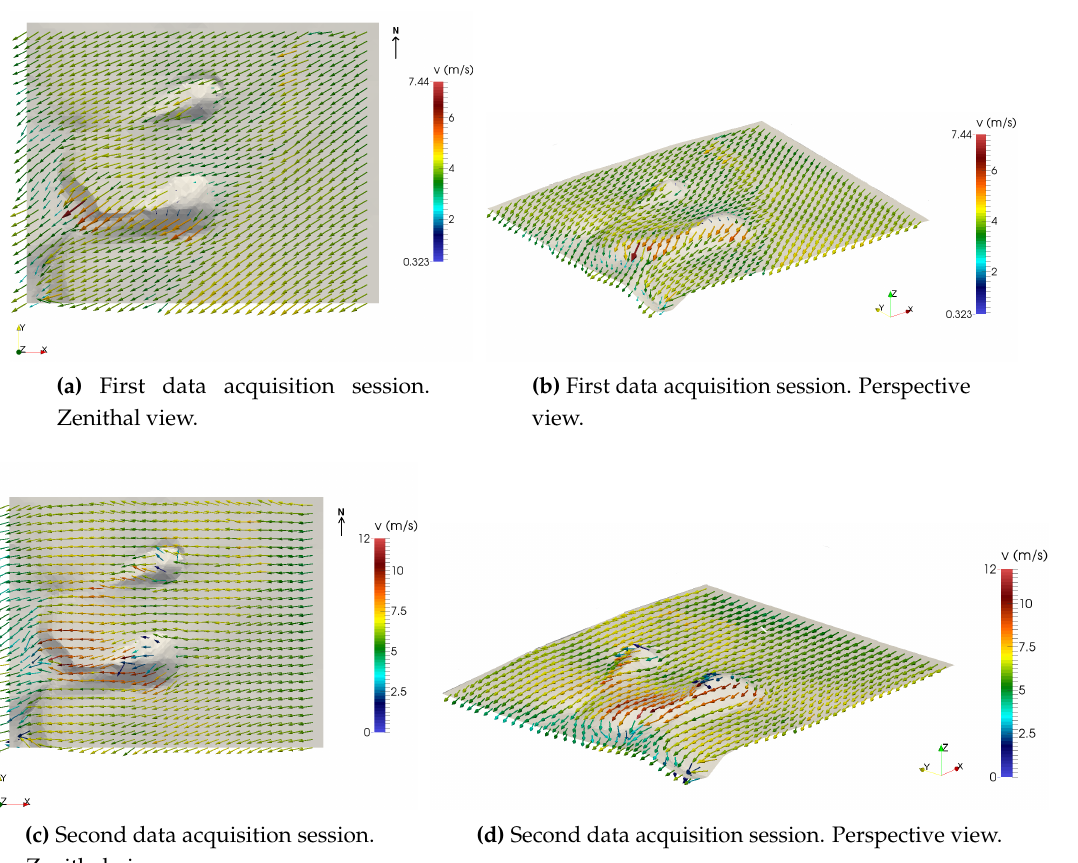
Figure 17. Topographic profile along the longitudinal axis of a tongue dune, with indication of the average speeds recorded by different sensors located on that axis for both data acquisition sessions.